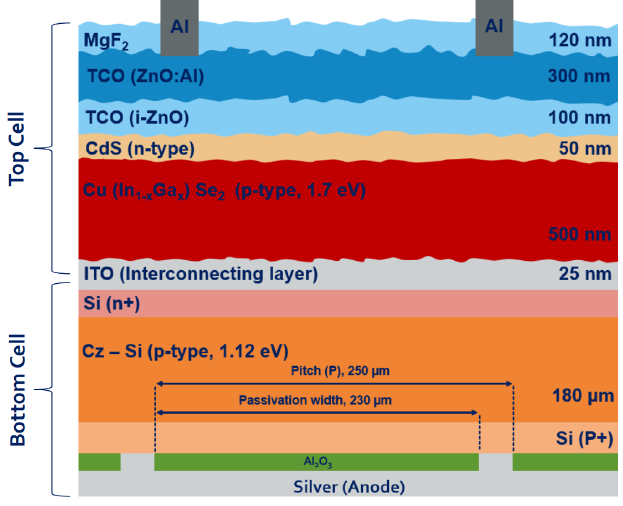
Figure 19. Schematic of optimized u-CIGS/C-Si PERT tandem solar cell.